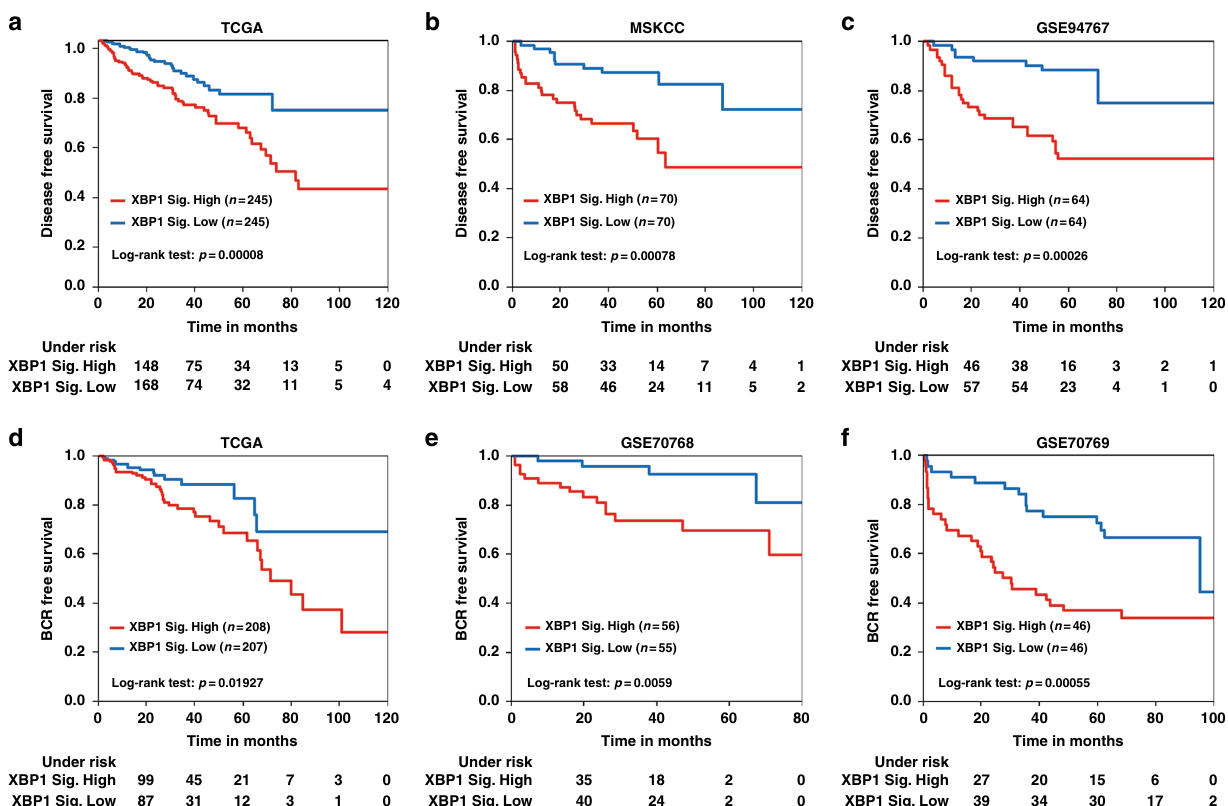
Fig. 5 XBP1 gene signature is strongly associated with prostate cancer prognosis. Kaplan – Meier graphs demonstrating a signi fi cant association between high expression of the XBP1 signature (red line) and shorter disease-free survival in the TCGA ( a ), MSKCC ( b ) and GSE94767 ( c ) patient datasets. Kaplan – Meier curves showing signi fi cant association of elevated XBP1 gene signature expression (red line) with shorter biochemical recurrence (BCR) free survival in TCGA ( d ), GSE70768 ( e ), and GSE70769 ( f ) cohorts of PCa patients. The log-rank test P values are